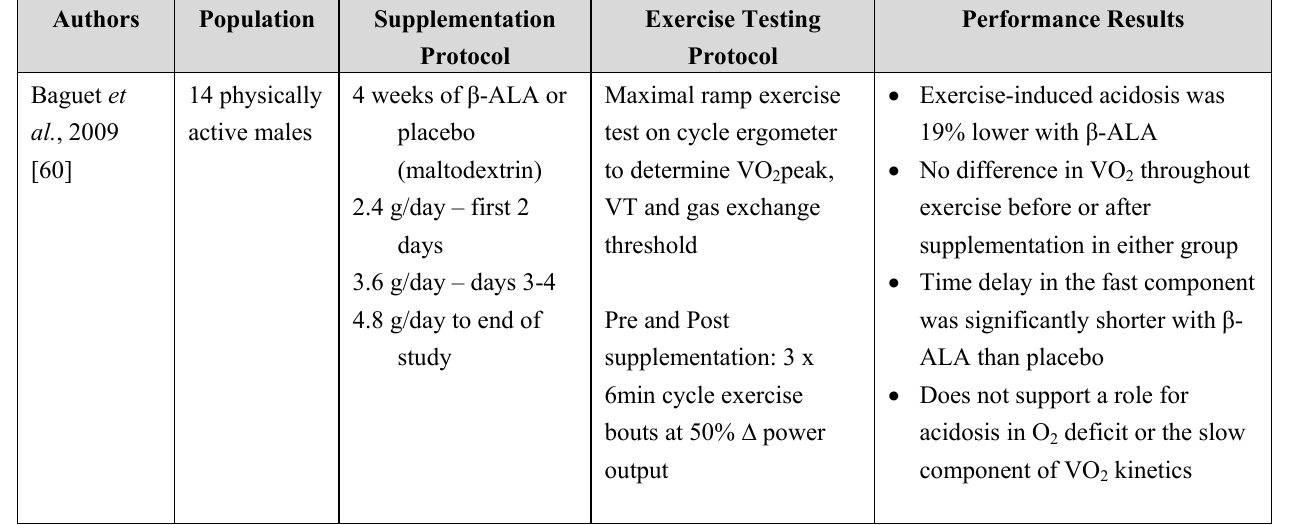
Table 2. Summary of recent β -ALA supplementation and exercise performance